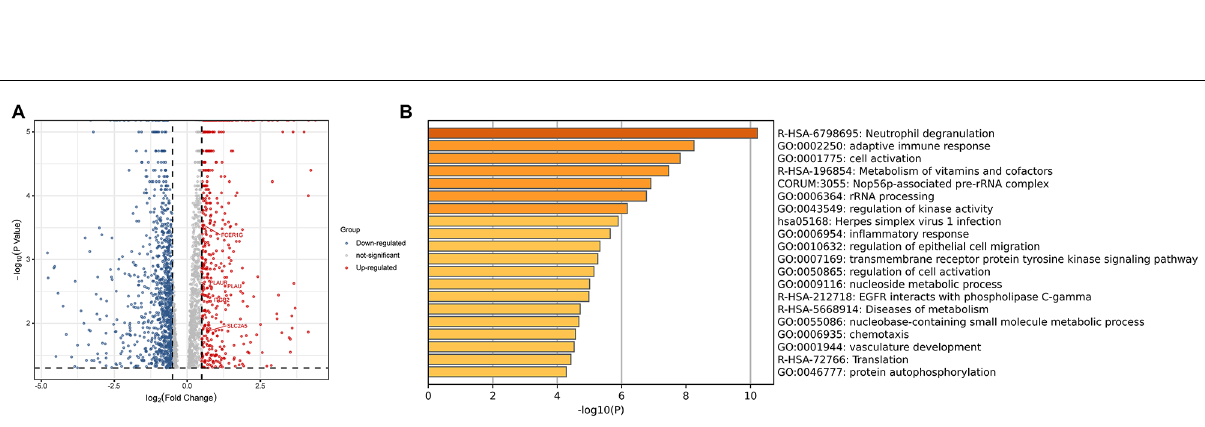
FIGURE 7 The miRNAs – target genes network. Circles and triangles represent miRNAs, blue diamonds represent hub genes, and triangles indicate two miRNAs with regulatory effects on both hub genes. Red ovals represent signaling pathways.